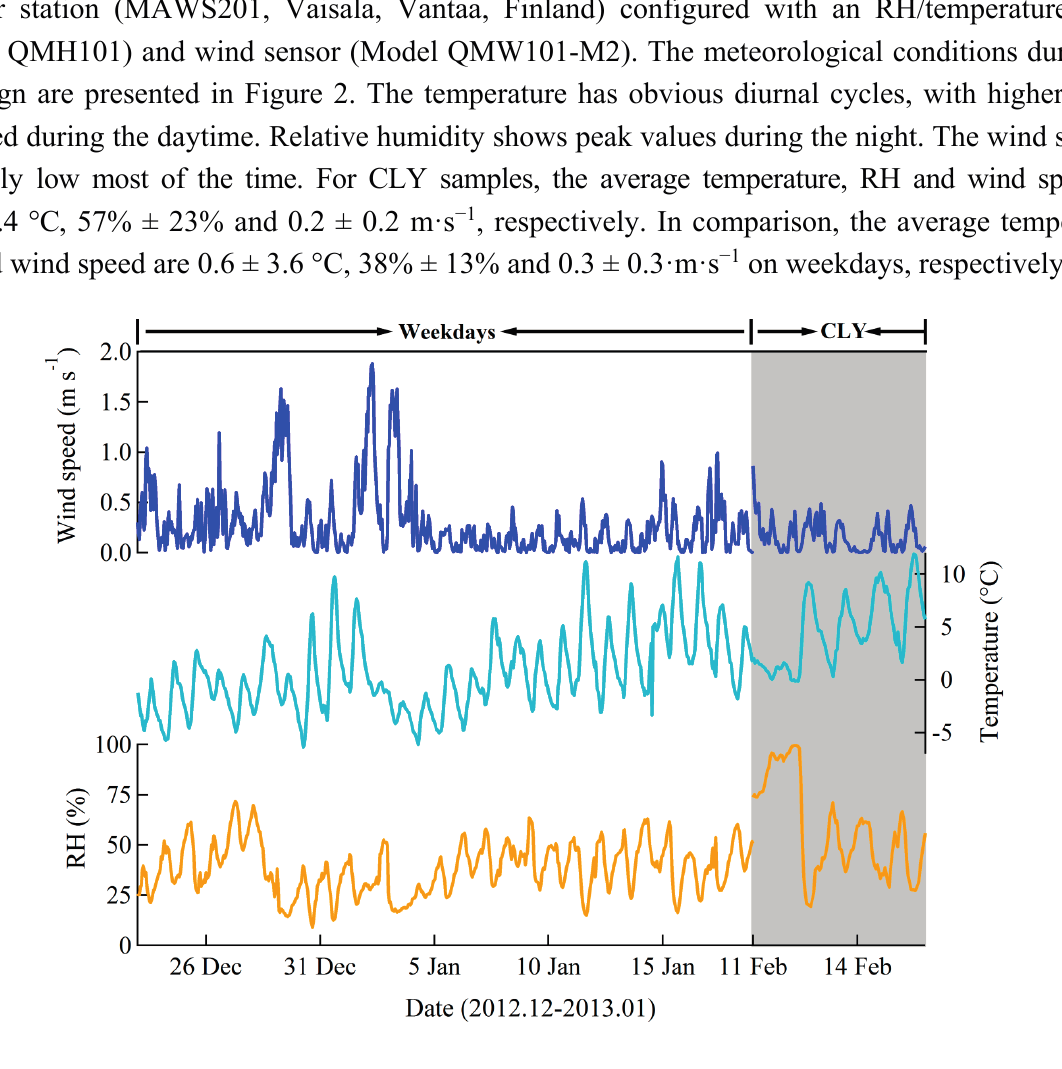
Figure 2. Time series of hourly averaged relative humidity (RH), temperature and wind speed during the Chinese Lunar Year (CLY) and on